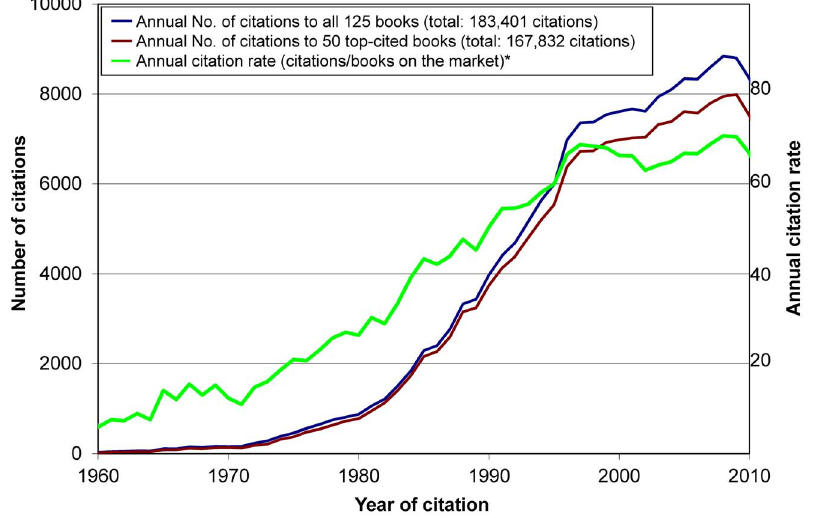
Figure 1. Total number of citations received by books included in the study each calendar year, and annual citation rate.* [ Footnote: *Annual citation rate: Number of citations received each year by the 122 books available in the market at each corresponding time divided by the number of the 122 books in the market at each corresponding time. ]